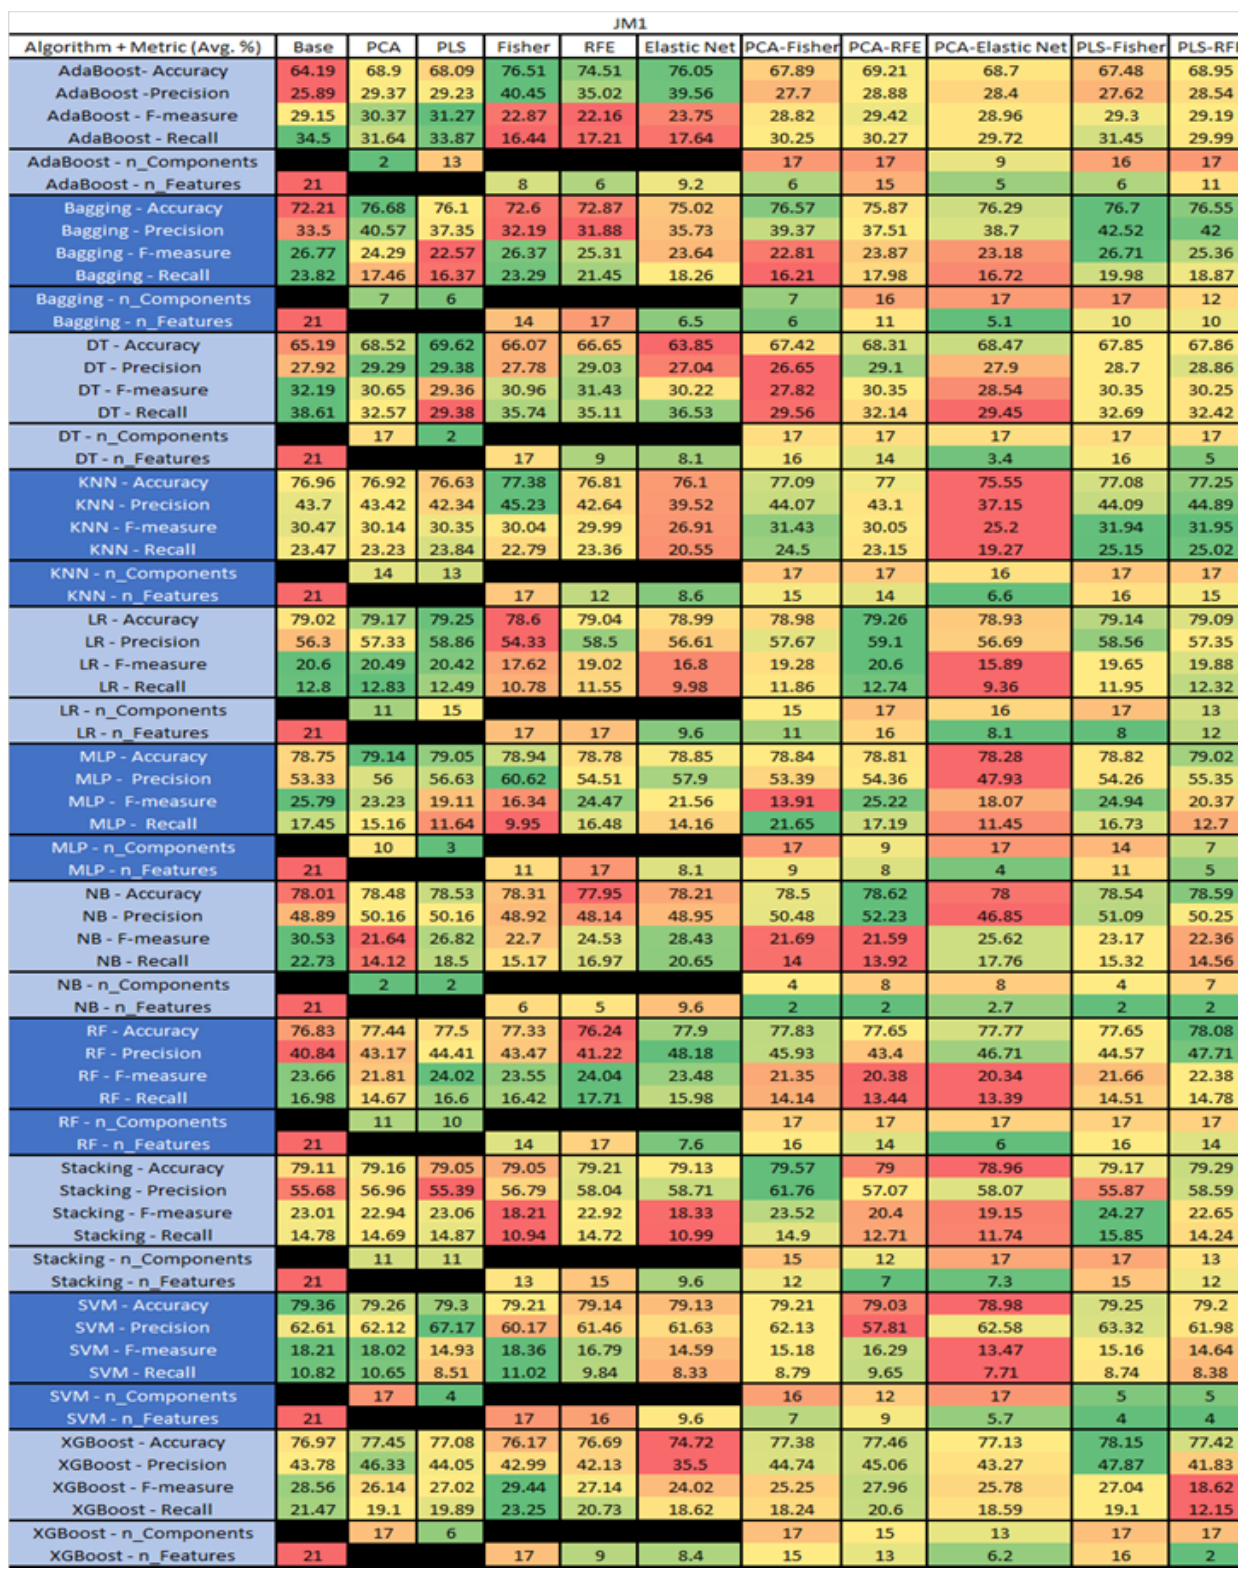
Figure 24. JM1 NASA MDP Results Data